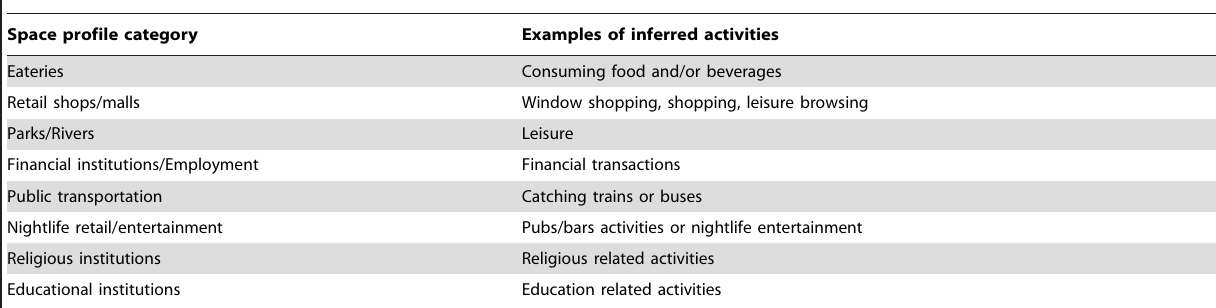
Table 1. Space profiles categories and corresponding